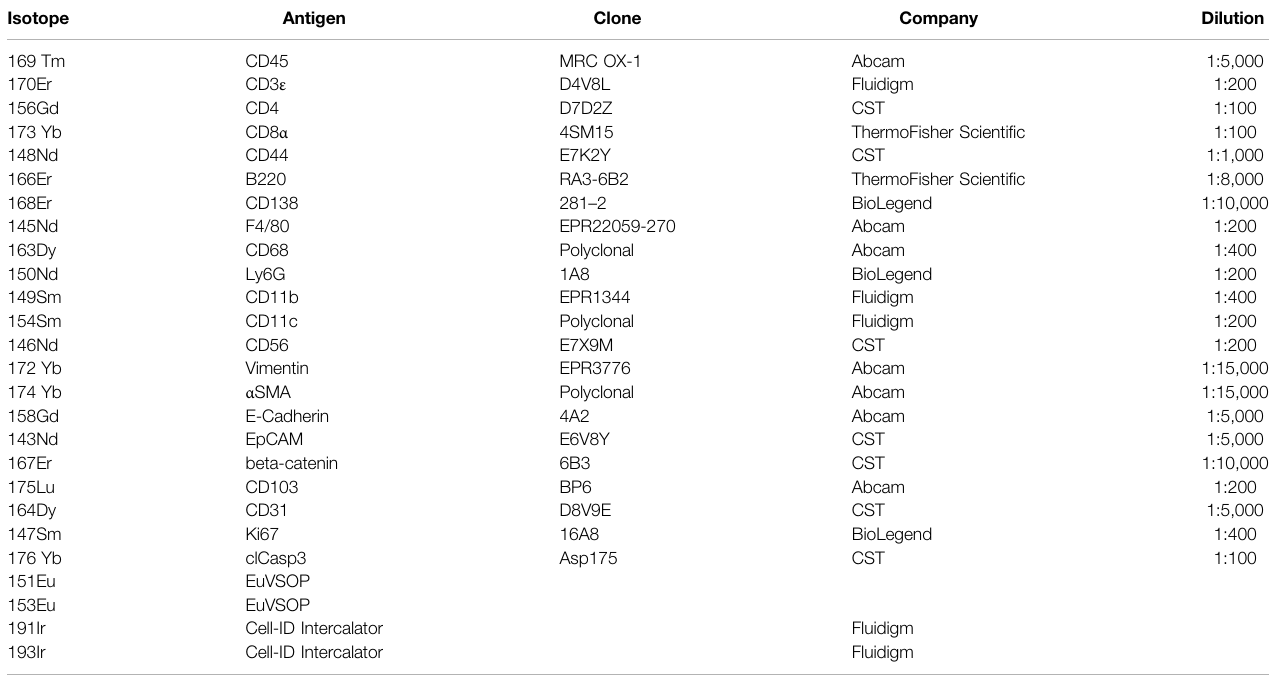
TABLE 1 | Antibody cocktail for imaging mass cytometry.